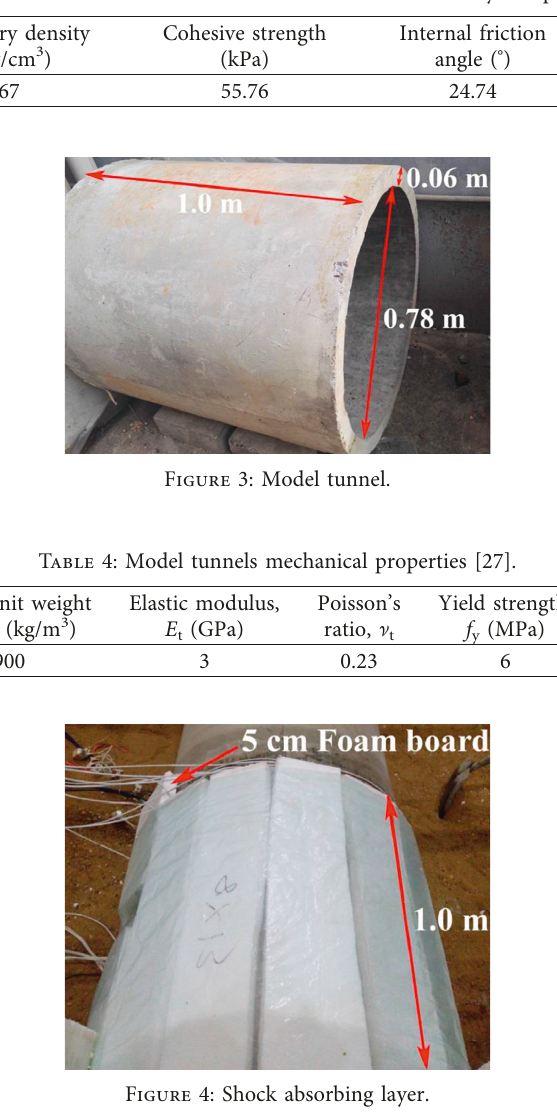
Table 3: Physical properties of clay soil [26, 27].